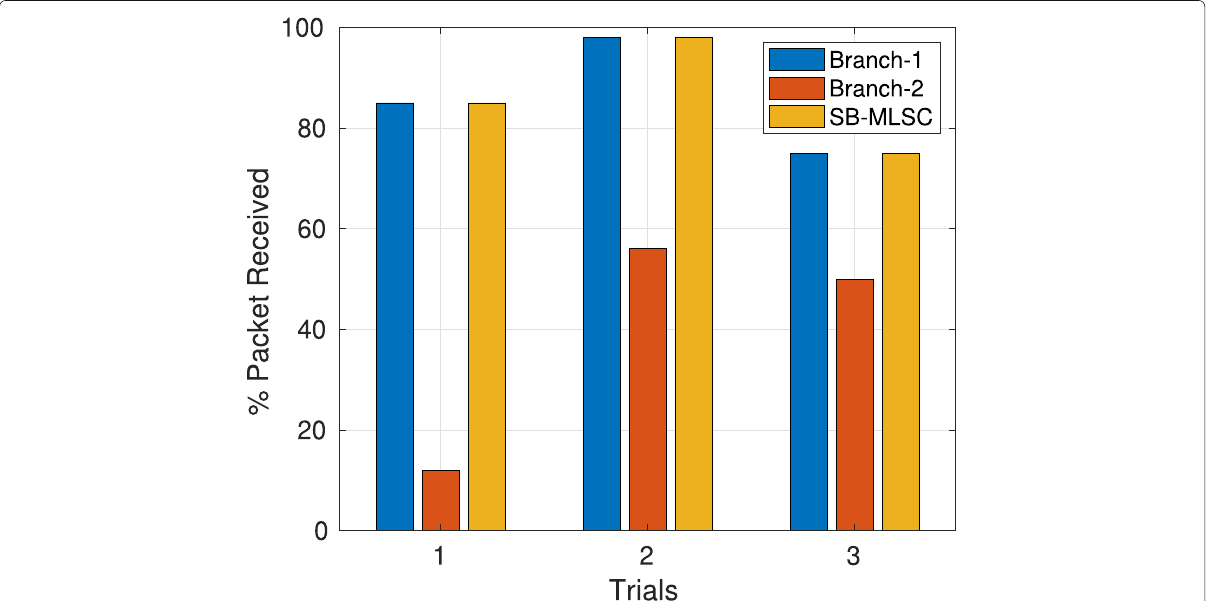
Fig. 20 Branch-2 is partially covered with aluminum foil and, thus, receives lesser packets than branch 1. In this case, SB-MLSC tracks branch 1 which receives more packet than branch